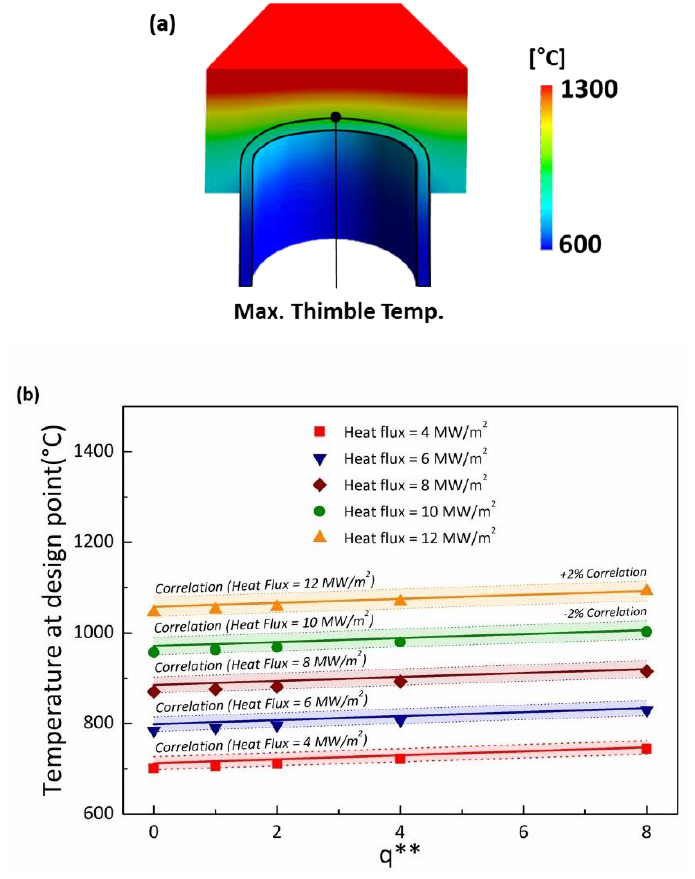
Figure 3. ( a ) Temperature distribution of divertor module at q * = 1.0 and q ** = 0.0 and ( b ) simulated and correlated results of maximum thimble temperature with change in normalized heat flux ( q *) and heat generation ( q** ).